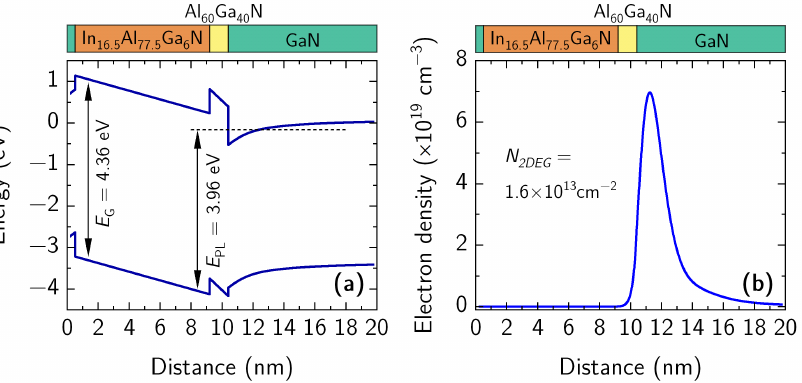
Figure 4. Band diagram ( a ) and 2DEG distribution ( b ) in the heterostructure calculated using the barrier composition determined from XRD measurements. A schematic representation of the heterostructure layout is provided above the